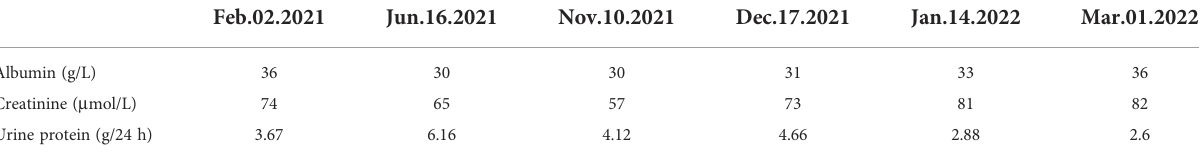
TABLE 1 The levels of serum albumin, serum creatinine, and urine protein on different